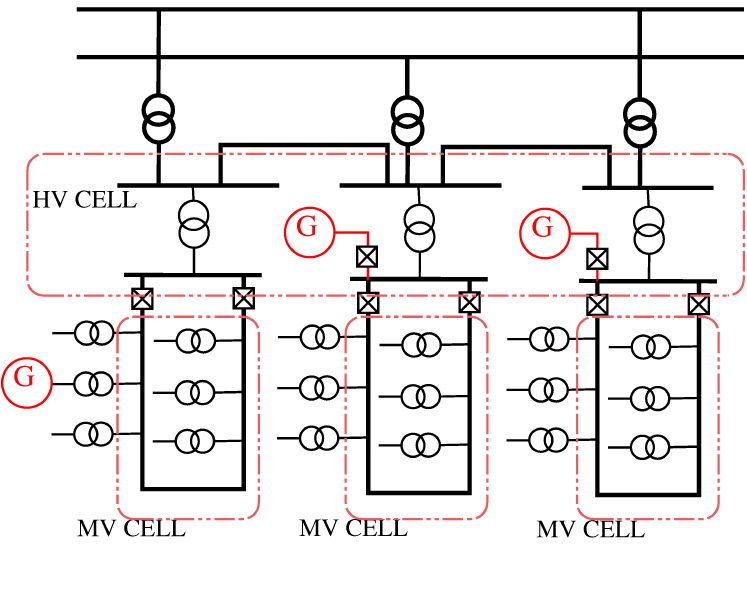
Figure 19. Distribution system organized by cells (local areas).